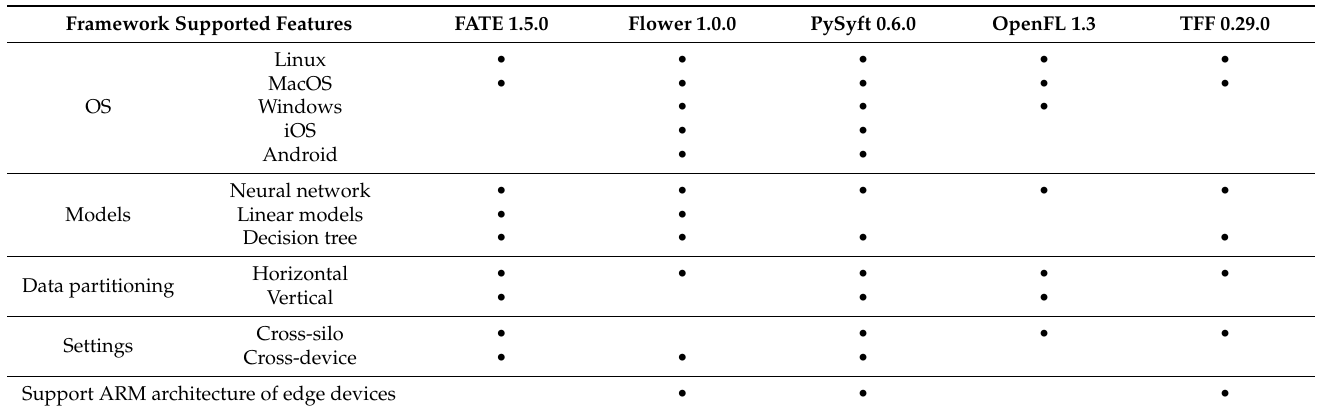
Table 2. Supported features of FL